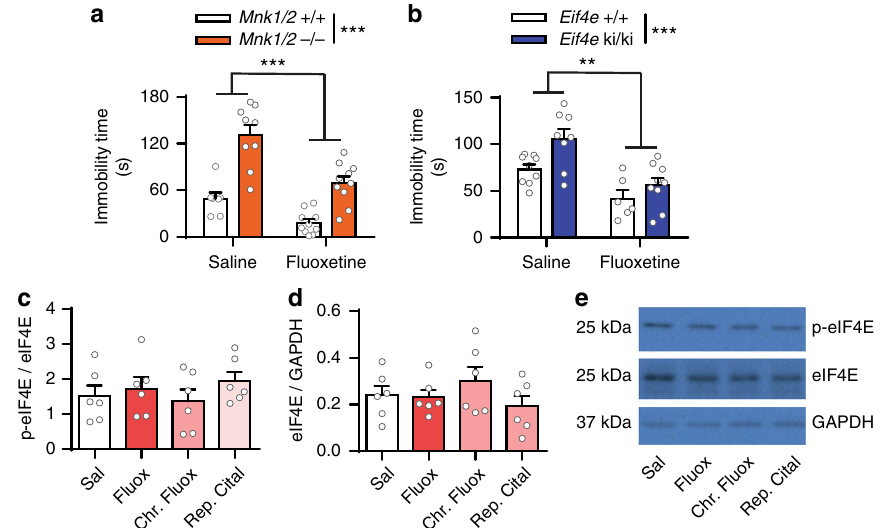
Fig. 3 Normal response to Fluoxetine in Eif4e ki/ki mice. a Male wild-type and Mnk1/2 − / − mice were treated with saline or fl uoxetine (IP, 3 mg kg − 1 ) and tested in the FST after 30 min ( n = 7 Mnk1/2 + / + Saline, n = 9 Mnk1/2 − / − Saline; n = 10 Mnk1/2 + / + Fluoxetine, n = 10 Mnk1/2 − / − Fluoxetine). b Male Eif4e + / + and ki/ki were also treated with saline or fl uoxetine (IP, 3 mg kg − 1 ) and performed the FST after 30 min ( n = 9 Eif4e + / + Saline, n = 8 Eif4e ki/ki Saline; n = 6 Eif4e + / + Fluoxetine, n = 9 Eif4e ki/ki Fluoxetine). c eIF4E phosphorylation in the mPFC/HPC of male wild-type mice treated with saline, 1 dose of fl uoxetine (0.5 h, IP, 3 mg kg − 1 ), chronic fl uoxetine (14 × , IP, 10 mg kg − 1 ) or repeated citalopram (3 × , IP, 10 mg kg − 1 ) ( n = 6/group). d Total eIF4E levels in the same samples as in ( d ). e Representative western blots for mice treated with vehicle or SSRIs. ** p < 0.01, *** p < 0.001 vs wild-type (see Supplementary Table 2 for detailed results of statistical